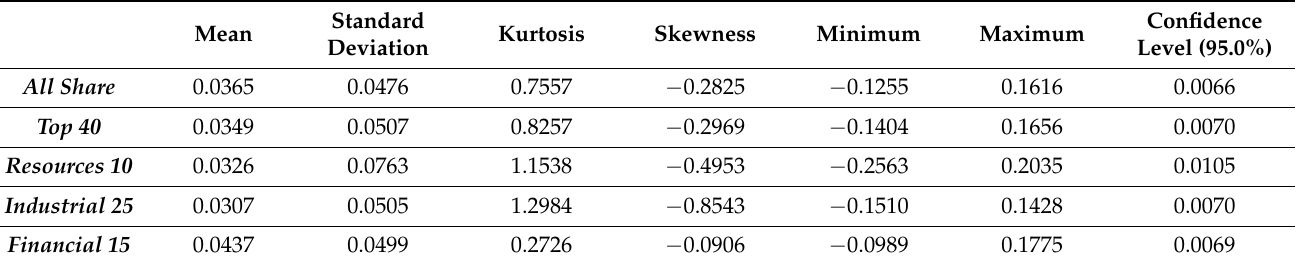
Table 3. Descriptive statistics of sectors used in research (January 2000 to December